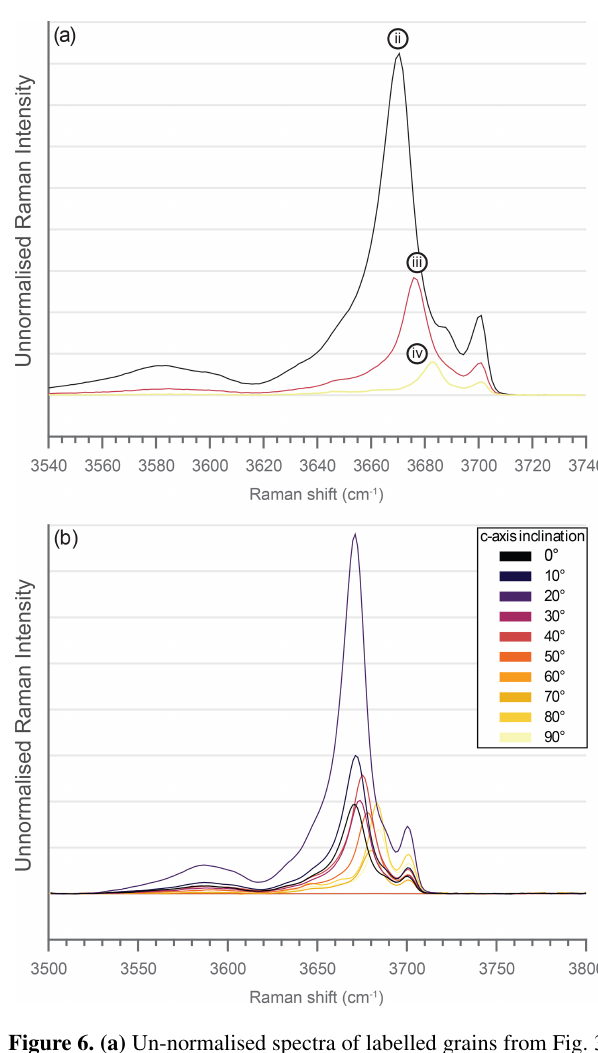
Figure 6. (a) Un-normalised spectra of labelled grains from Fig. 3. (b) Un-normalised spectra from SCGSM